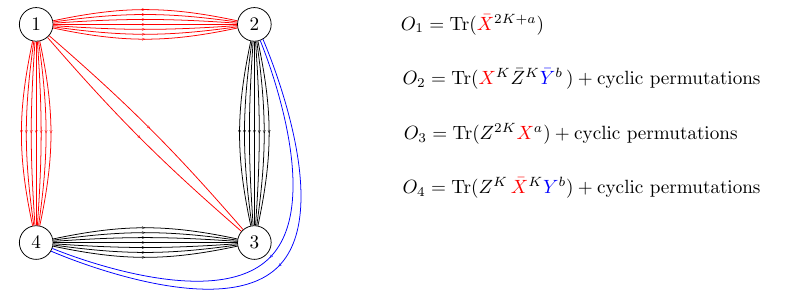
Figure 5 . A family of simple four-point functions. The polarization choices ensure that a single Wick contraction exists in the field theory. K is assumed to be larger than loop order so as to make the four exterior bundles effectively